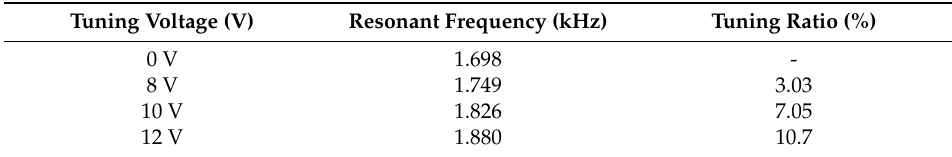
Table 3. Resonant frequency shifts achieved by the shaft ‐ holding type. Reproduced with permission from [26].